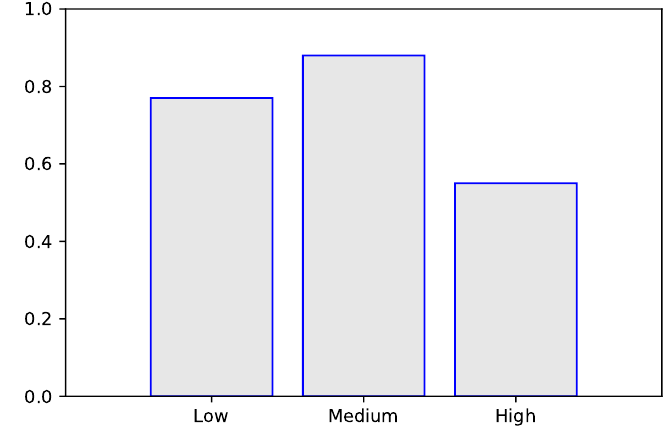
Figure 7. The model prediction of number of appliances. Table 7. The confusion matrix of electrical appliances.